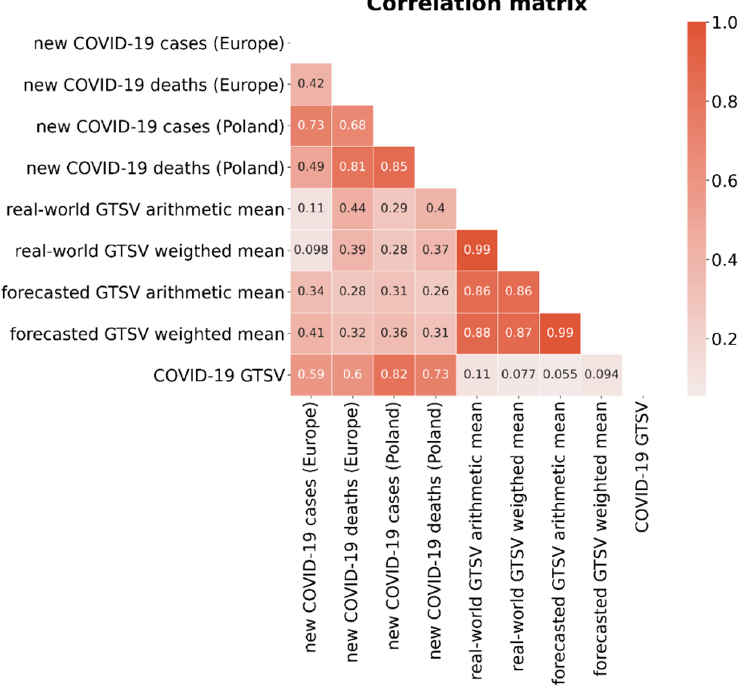
Figure 5. Pearson product–moment correlation coefficient matrix regarding the mean monthly changes in COVID-19 pandemic metrics and GTSVs.